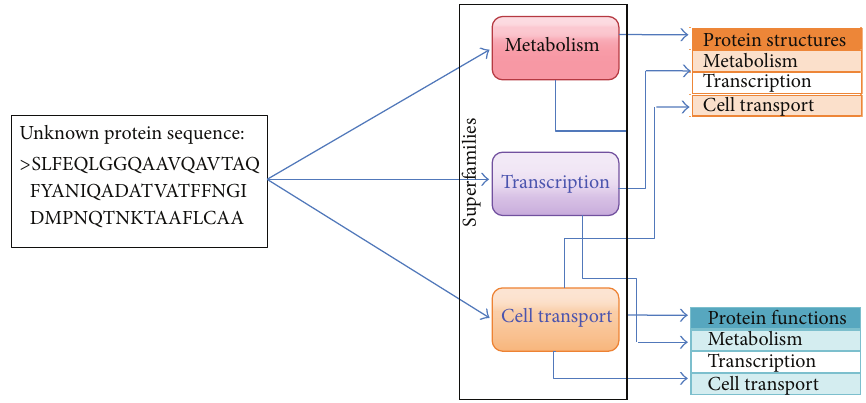
Figure 1: Prediction of the structure or function of an unknown